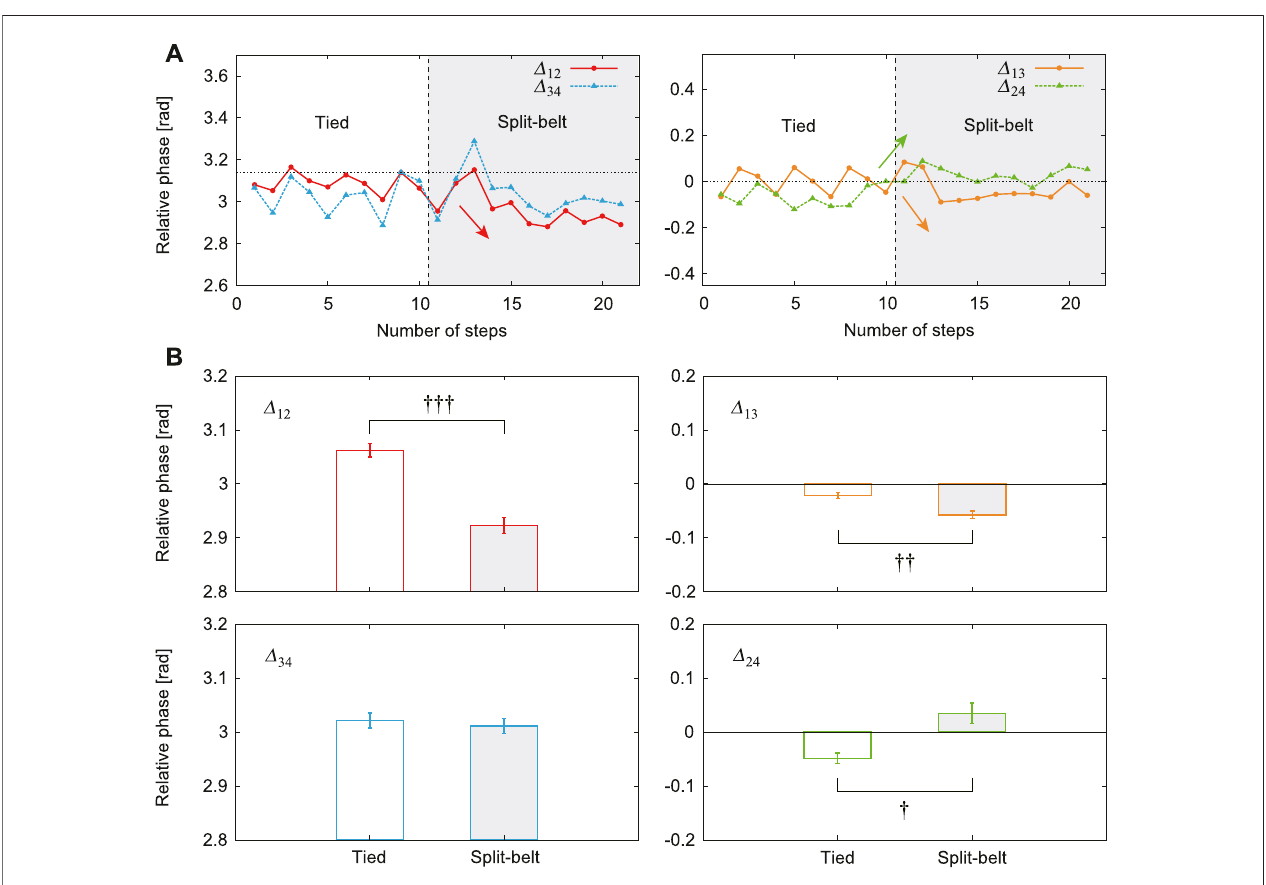
FIGURE 4 | Relative phases between leg oscillators with use of only spinal model. (A) Δ 12 , Δ 13 , Δ 24 , and Δ 34 for one representative trial of 5x condition. (B) Their averages for tied and split-belt con fi gurations. Data points and error bars are the mean and standard error results of fi ve experiments, respectively. † : p < 0 . 05, †† : p < 0 . 01, and ††† : p < 0 .